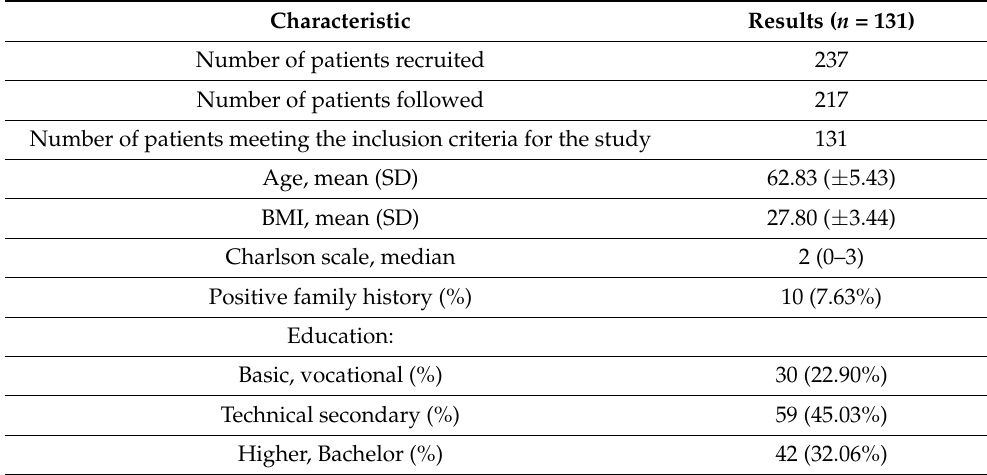
Table 1. Demographic characteristics of the study group.